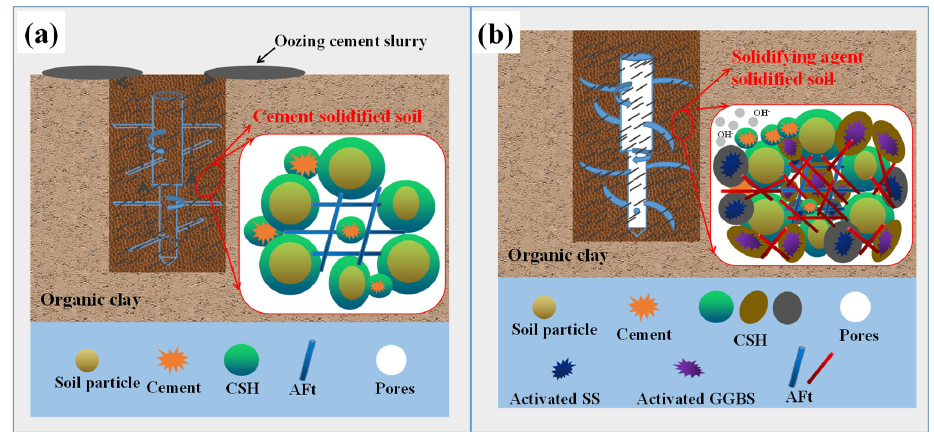
Figure 11. The solidification mechanism diagrammatic sketch of ( a ) the conventional cement deep mixing pile and ( b ) the solidifying agent deep mixing pile.